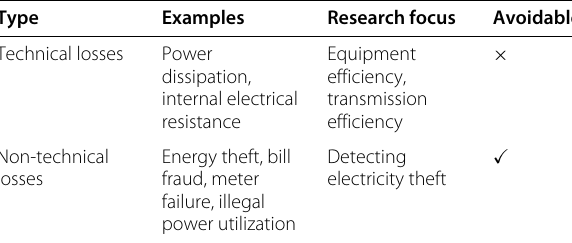
Type Examples Research focus Avoidable Technical